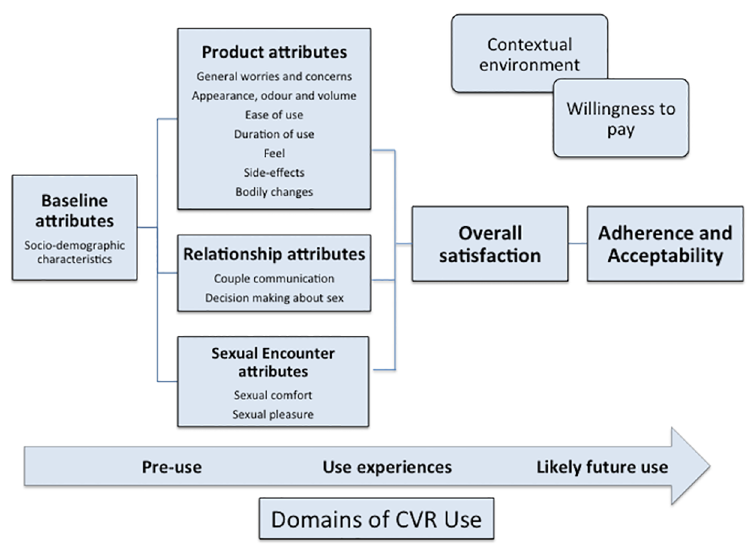
Fig 3. Theoretical framework used for data collection and analysis as adapted from Van der Straten et al [38] and Merkatz et al [40]. The framework proposed by van der Straten et al [35] was used for data collection and